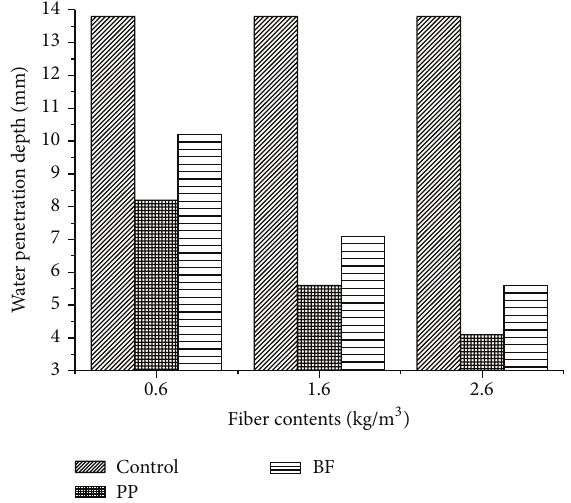
Figure 9: Water penetration depth of FRM at different fiber contents.